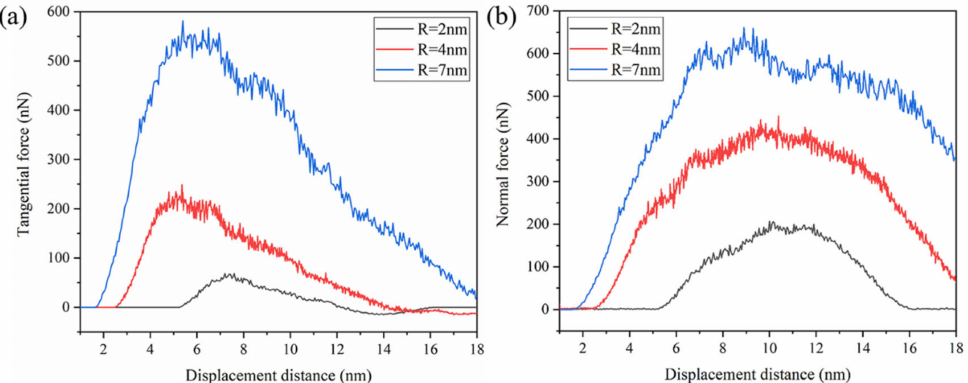
Figure 10. Force–displacement curve of plowing with different asperity sizes in the ( a ) tangential direction and in the ( b ) normal direction.